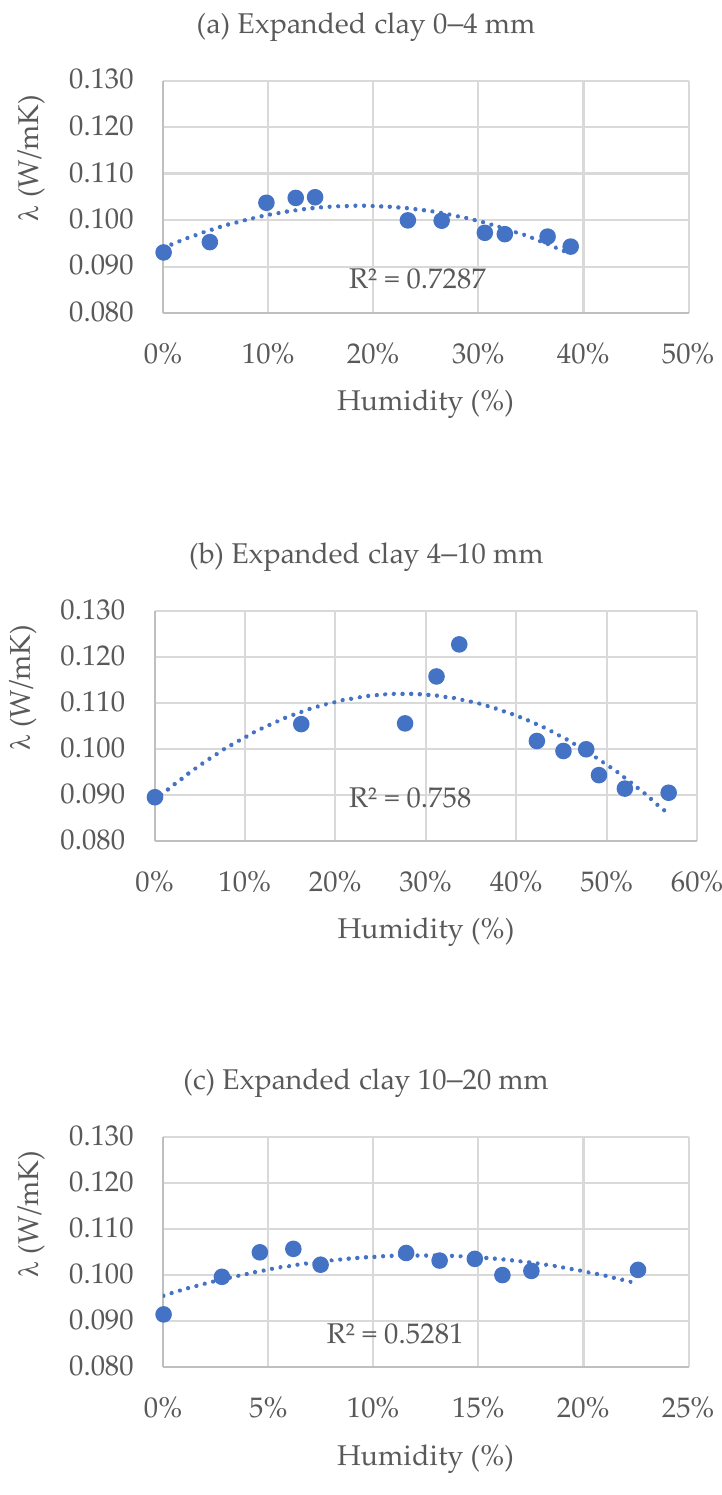
Figure 5. Example of the nonlinear correlation for measurements of expanded clay, ( a ) expanded clay 0–4 mm, ( b ) expanded clay 4–10 mm, ( c ) expanded clay 10–20 mm. Calculations were made for the remaining series of measurement data for expanded clay. The summary of correlation coefficients for each series is presented in Table 4. Table 4. Correlation coefficients for the polynomial correlation function.